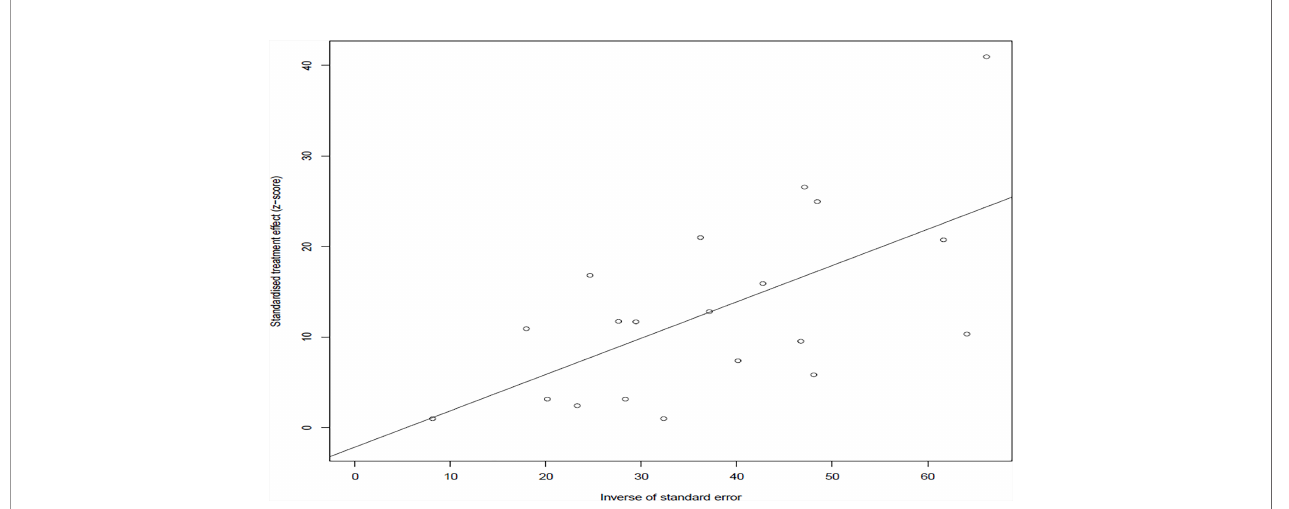
FIGURE 4 | Publication bias of included studies by Egger ’